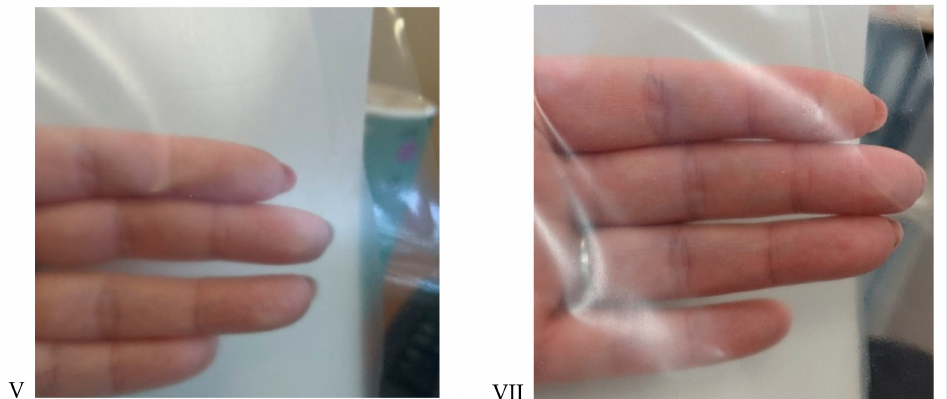
Figure 7. The images of the V coating containing a mixture of CO 2 extracts of raspberry seeds and of rosemary and the VII coating containing a mixture of CO 2 extracts of raspberry seeds, of pomegranate seeds and of rosemary.